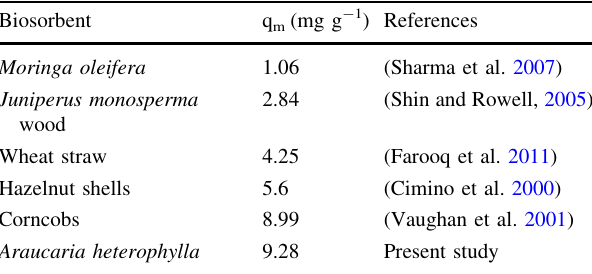
Table 2 Comparison of maximum metal uptake ( q m ) for biosorption of cadmium with other biomass